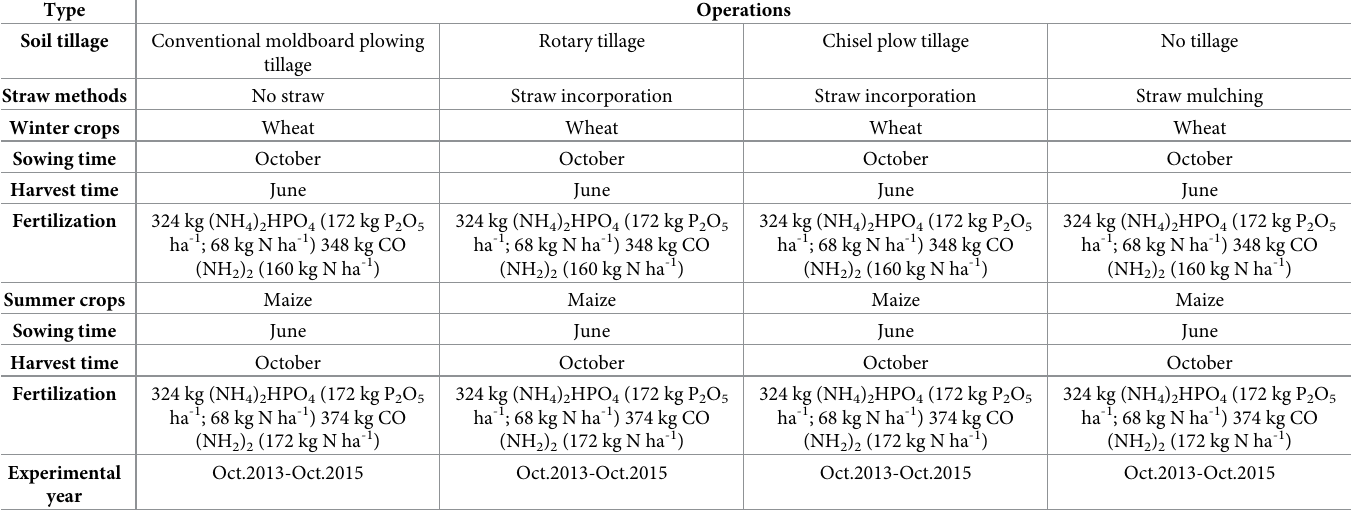
Table 1. Summary of experimental design with four tillage treatments on Loess Plateau in China. Type